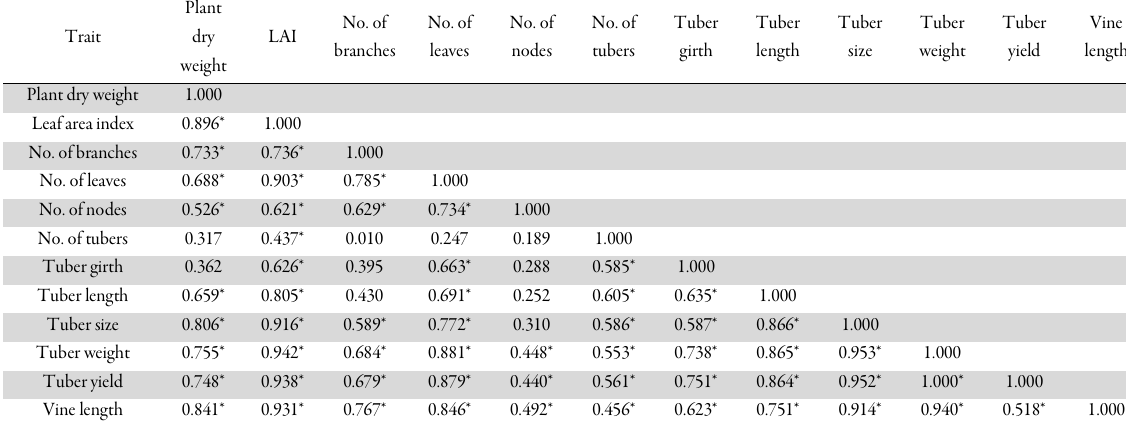
ns - Not significant at 0.05 level of probability Table 5. Correlation coefficients among growth and yield variables of sweet potato Trait